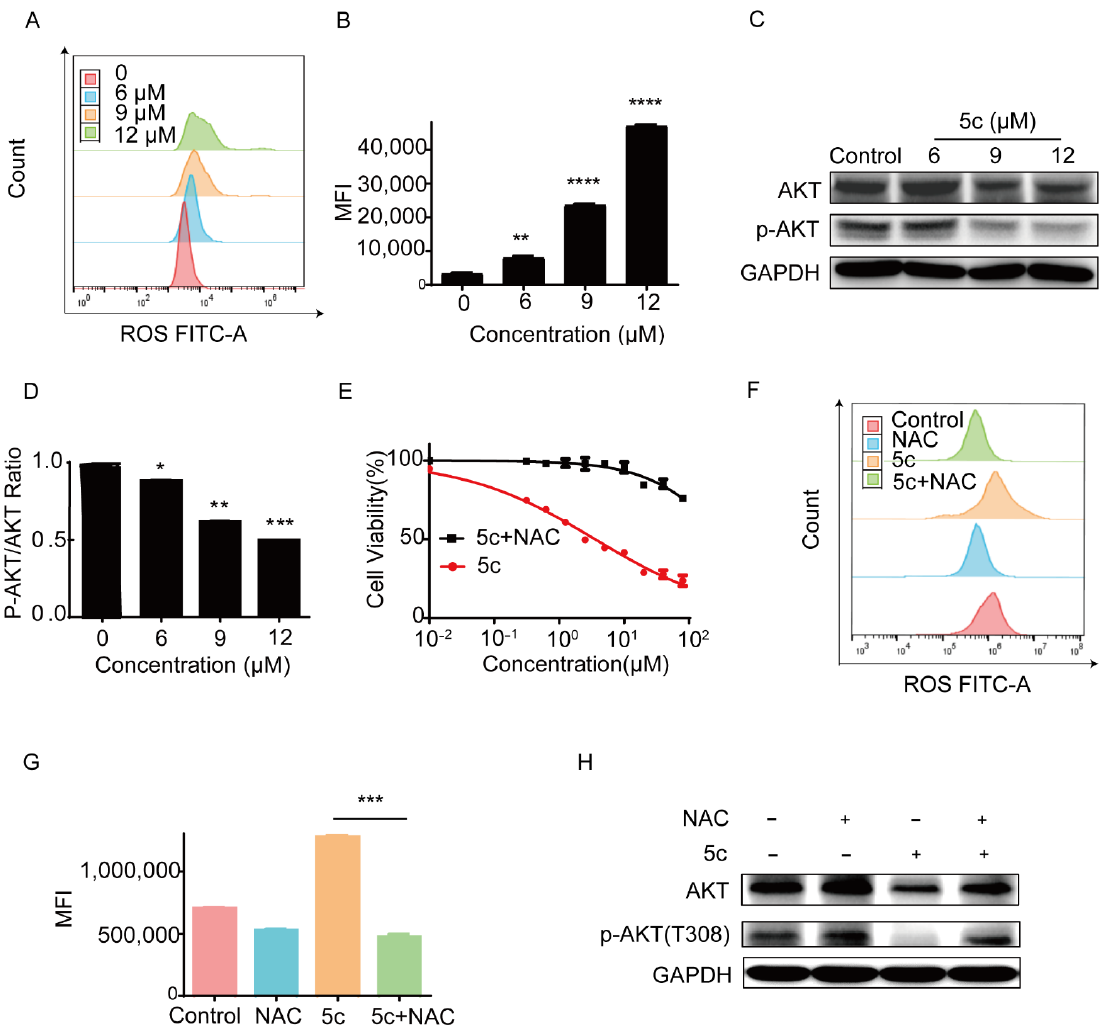
Figure 7. Compound 5c induces intracellular ROS generation and inhibits AKT phosphorylation. ( A ) Concentration-dependent induction of ROS content in HeLa cells by compound 5c for the 6 h interval. ( B ) Quantitative statistics of the results shown in A using GraphPad software. ( C ) Concentration-dependent phosphorylation inhibition of AKT in HeLa cells by compound 5c for the 6 h interval. ( D ) Quantitative statistics of the results in C using Image J software. ( E ) HeLa cells were pretreated with NAC (5 mM, 1 h) before incubation with compound 5c for a 24 h interval. The CCK-8 assay showed that NAC increased the IC 50 value of compound 5c and decreased its cytotoxicity. ( F ) HeLa cells were pretreated with NAC (5 mM, 1 h) before incubation with compound 5c for a 6 h interval. The flow cytometry results showed that NAC inhibited the effect of 5c -induced ROS generation. ( G ) Quantitative statistics of the results in F using GraphPad software. ( H ) HeLa cells were treated in the same way as in F; Western blot experiments showed that 5c inhibited AKT (T308) phosphorylation, and NAC almost eliminated this effect. Values are presented as the means ± SDs from three independent experiments. * p < 0.05, ** p < 0.01, *** p < 0.001. **** p < 0.0001.